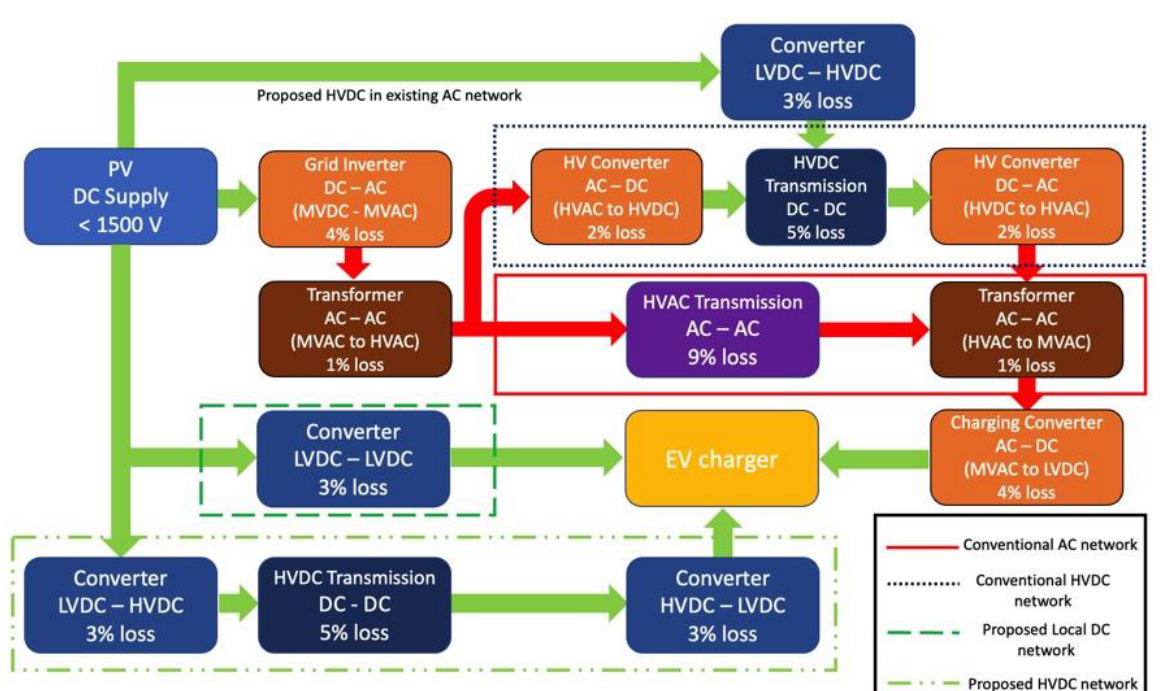
Energies 2021 , 14 , x FOR PEER REVIEW